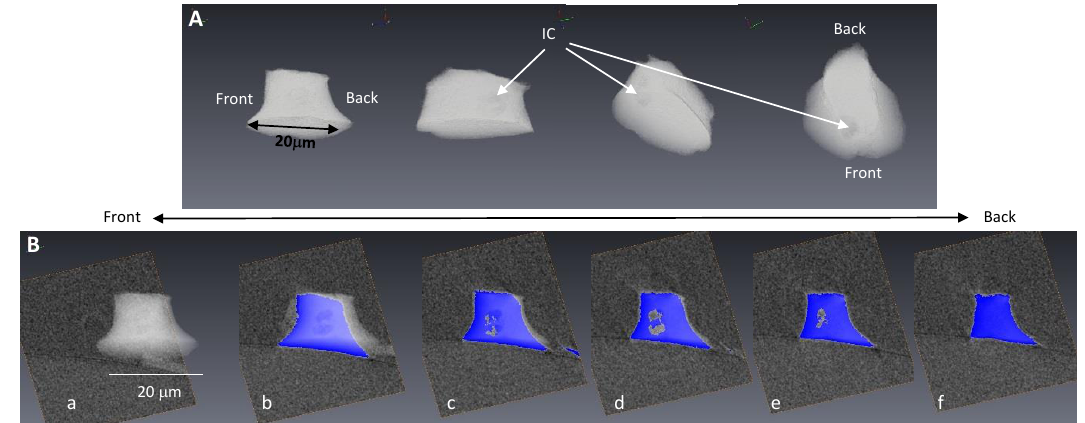
Figure 4. 3-D X-ray microscopy of a GSC phytolith from wheat (TD-F-L): (a) four views of the reconstructed volumes; internal cavities (IC) are distinguishable. (b) 2-D X-ray slices superimposed on the phytolith volume rendering, showing from front to back the internal cavity (IC). No connection to the surface was evidenced. The blue area corresponds to the thresholding of the phytolith grayscale values.